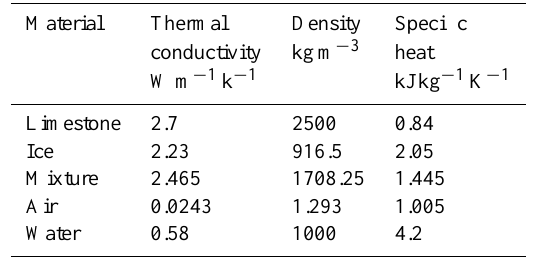
Table 2. Gr number and constant for different flow types (Yang and Tao,